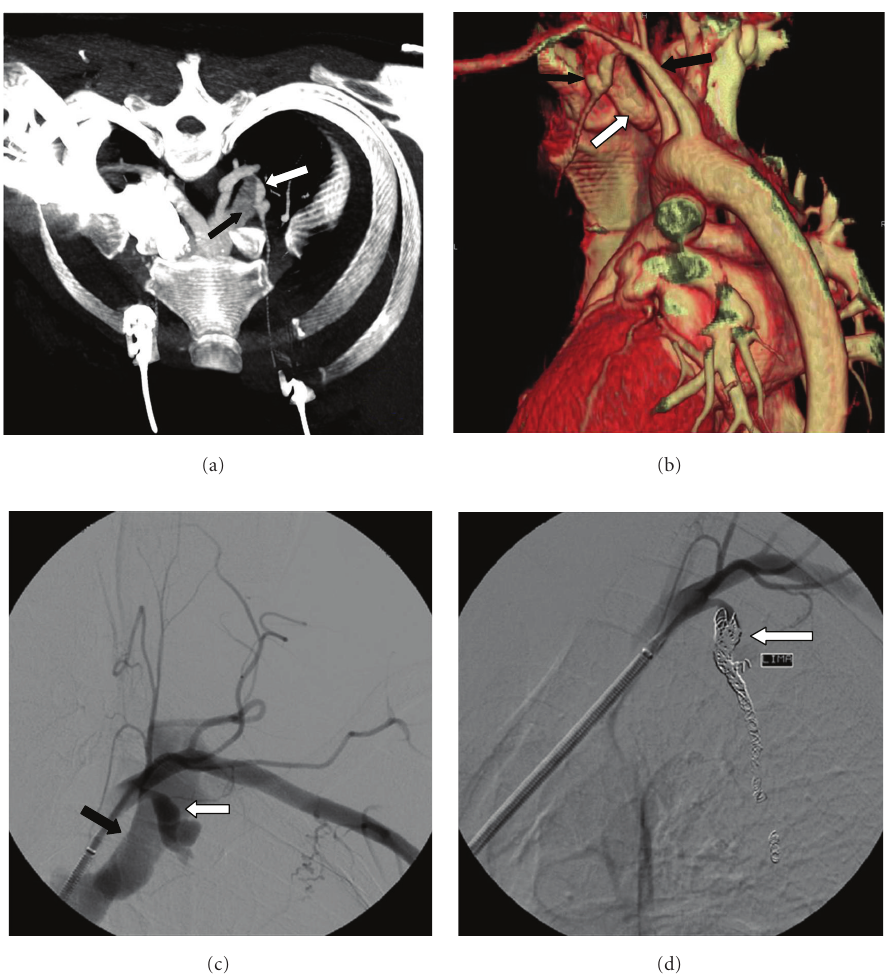
Figure 1: (a) Volume-rendered image showing aneurysmal dilatation of the LIMA (white arrow) fistulized with the left brachiocephalic vein (black arrow). (b) Three-dimensional reconstructed images show aneurysmal dilatation of the LIMA (smallblack arrow) near its origin from the subclavian artery (large black arrow) and its relationship with the left subclavian and brachiocephalic vein (white arrow). (c) Selective arteriogram of the subclavian artery demonstrating aneurysmal dilation of proximal LIMA (white arrow) and fistulization with the left brachiocephalic vein (black arrow). (d) Successful coil embolization of LIMA (arrow) showing closure of